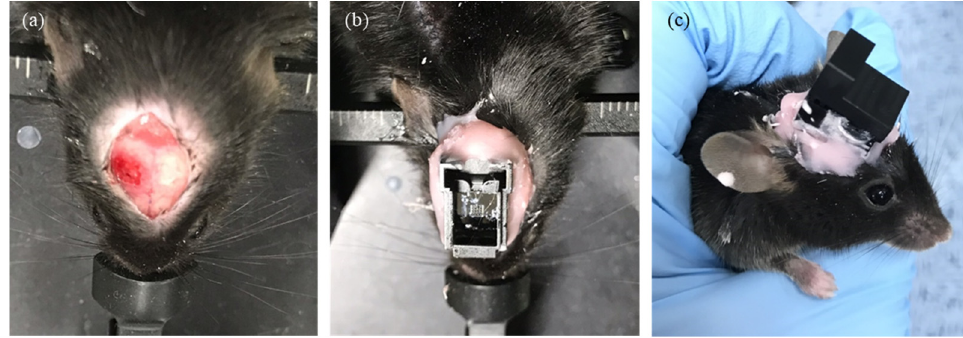
Figure 5. MOA implantation surgery: ( a ) target brain area was exposed by drilling into the skull; ( b )